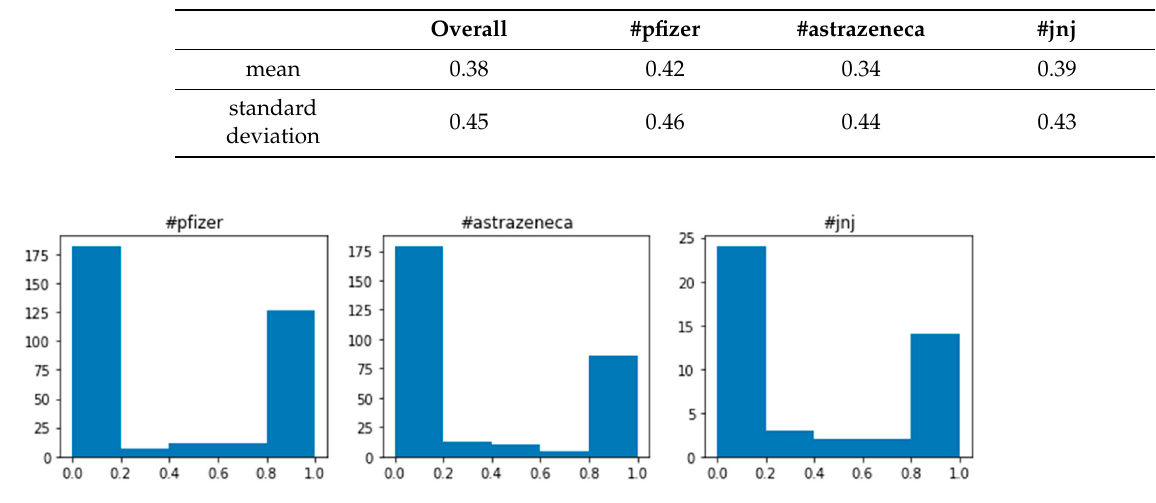
Figure 13. Polarity distributions.